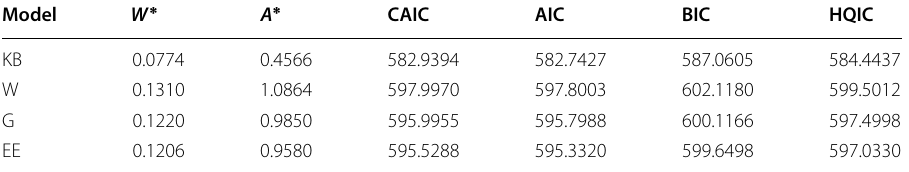
Table 6 Information criteria for dataset 2